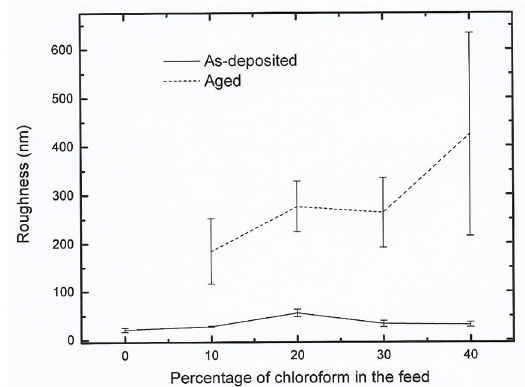
for the as-deposited Cl